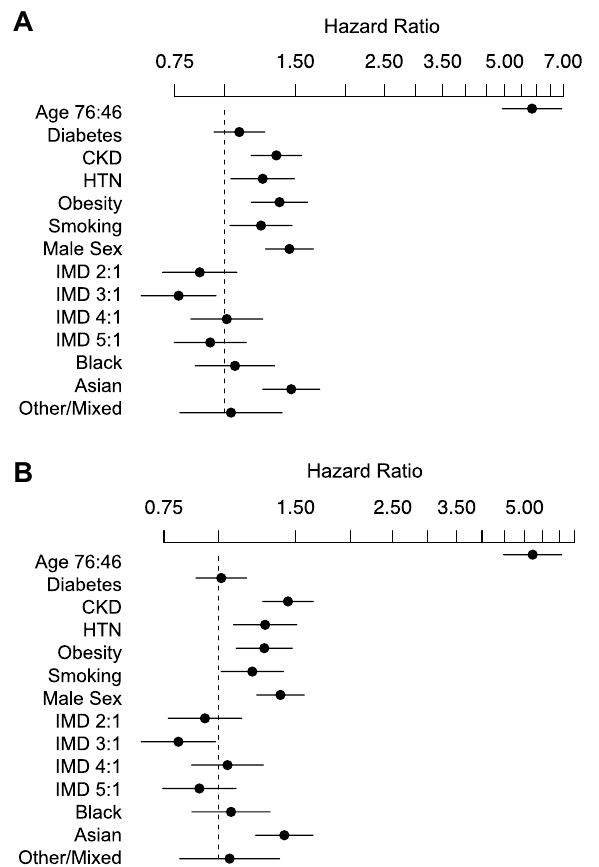
Figure 1. Cox-proportional Hazard analysis included covariates: Age, Sex, Hypertension, Diabetes, Chronic Kidney Disease, Smoking history, Obesity, IMD (quintiles of local study population) for survival over 30 ( A ) and 90 ( B ) days in the second pandemic wave ETHICAL